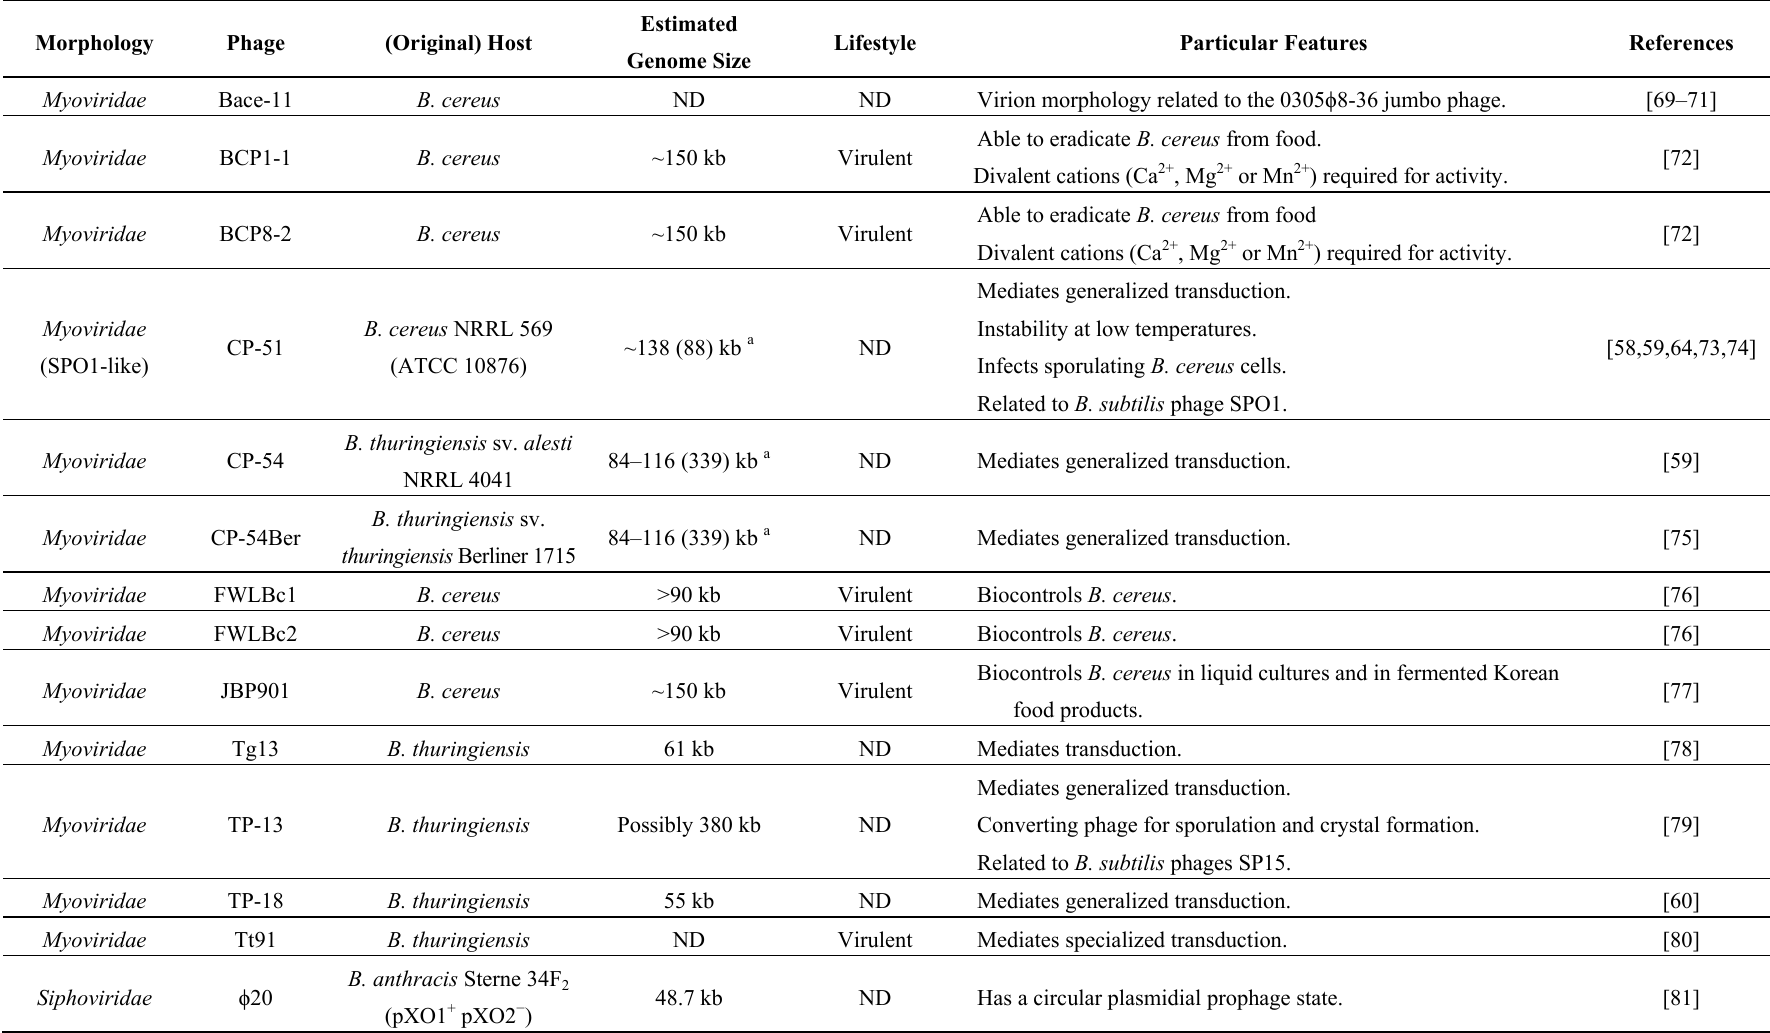
Table 3. Main features of B. cereus , B. anthracis and B. thuringiensis phages referred in this work whose DNA sequences have not been